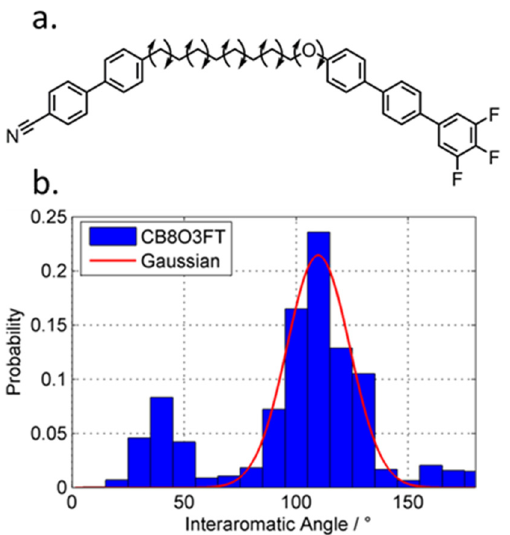
Figure 5. Conformational studies on an isolated molecule: ( a ) the structure of CB8OFFFT , where arrows are used to indicate bonds allowed to undergo threefold rotation (twofold for Ph-O); ( b ) histogram plot of the probability of a given interaromatic angle with a Gaussian fit to the major (bent) peaks.